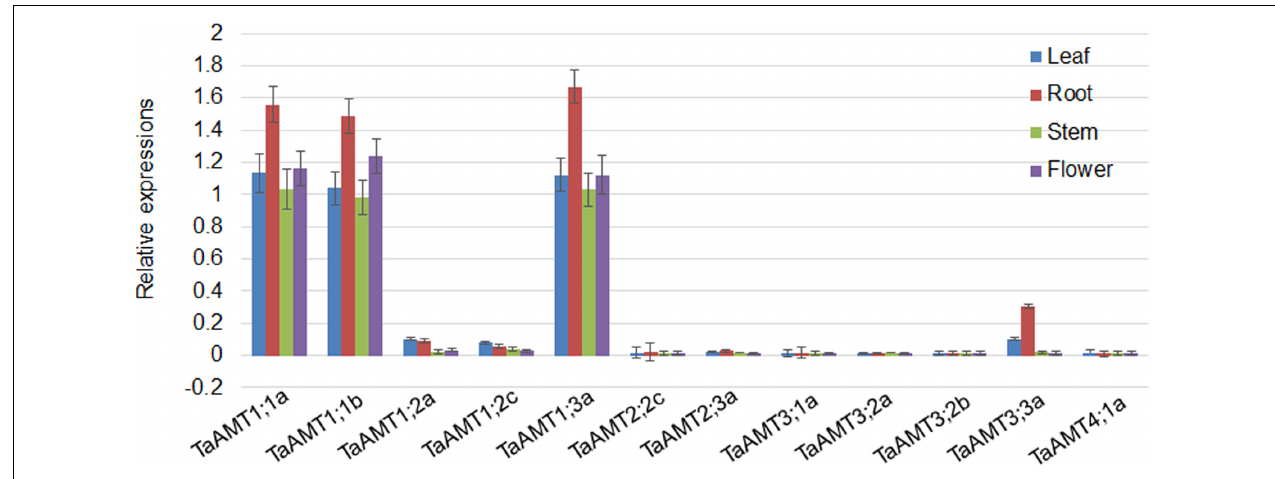
FIGURE 2 | Tissue-specific expression of TaAMT genes in wheat. Expression levels of TaAMTs in the leaves, roots, stems, and flowers were analyzed. The expression patterns were analyzed by qRT-PCR. The TaEF1 α gene was used as the internal control. The experiments were repeated three times.